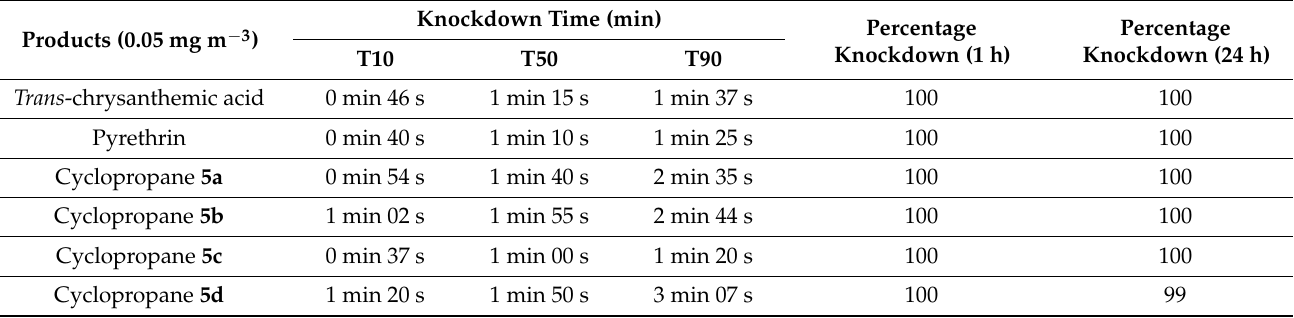
Table 3. Biological efficacy of cyclopropanes 5a–d versus trans-chrysanthemic acid and pyrethrin as a space spray in 22.5 m 3 chambers against Aedes aegypti